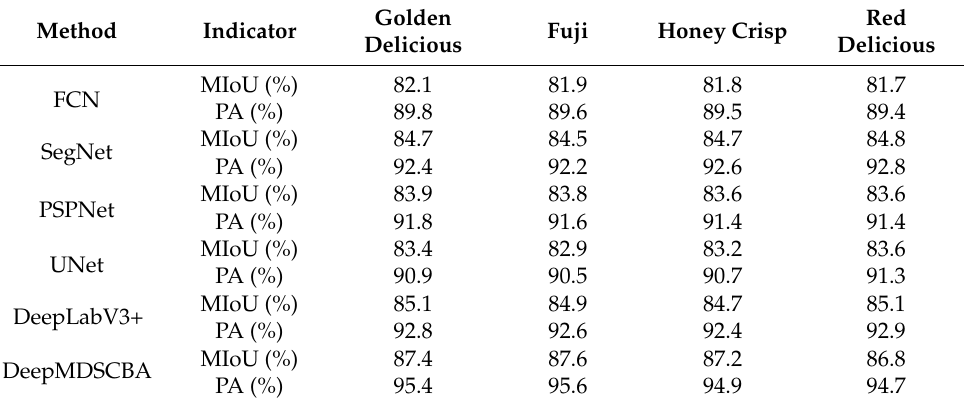
Table 10. Segmentation performance of apple images of different varieties.